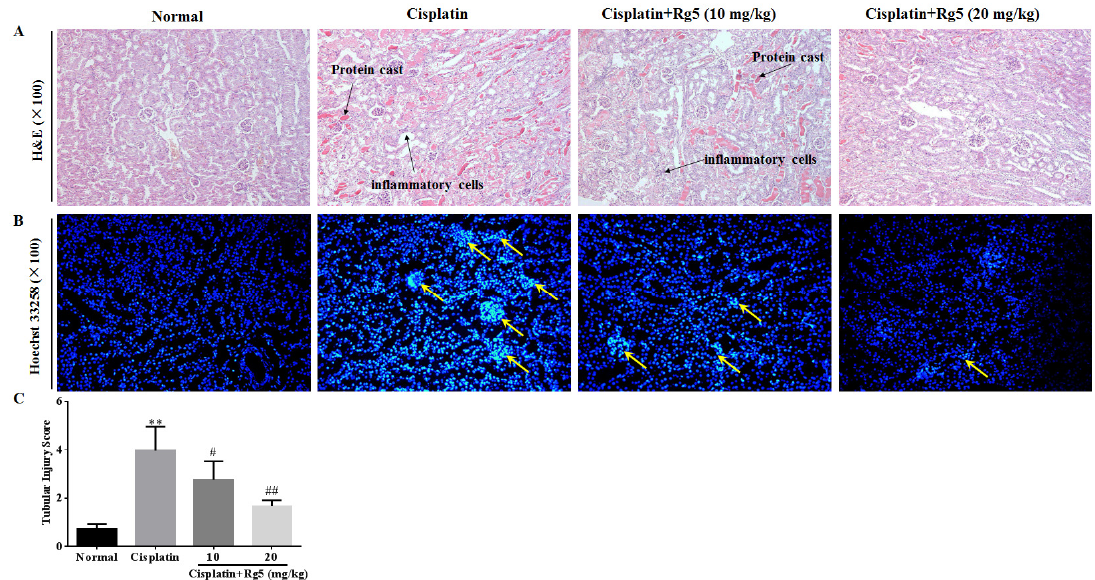
Figure 7. Histological examination of morphological changes in kidney tissues. Renal tissues stained with: hematoxylin ‐ eosin (H&E) (100×) ( A ); and Hoechst 33258 (100×) ( B ); and the tubular injury scores ( C ). Arrows show necrotic and injured epithelial cells, stars show cast formation. All data were expressed as mean ± S.D., n = 8. ** p < 0.01 vs. normal group; # p < 0.05, ## p < 0.01 vs. cisplatin group.